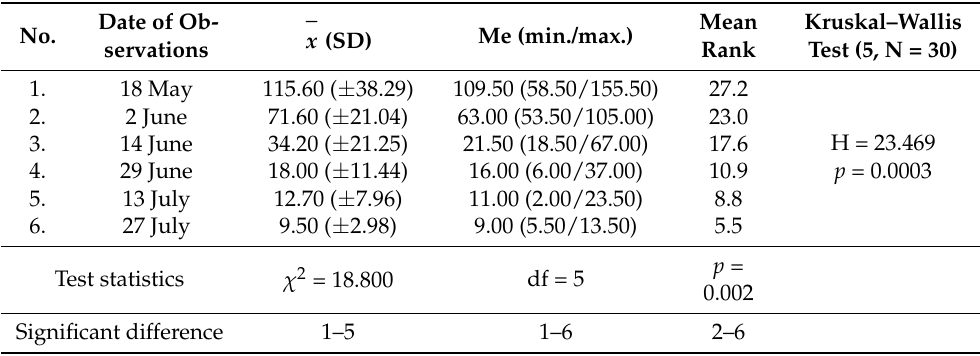
Table 3. Kruskal–Wallis test results: number of flowering plants in the flower strip in relation to the date of observation